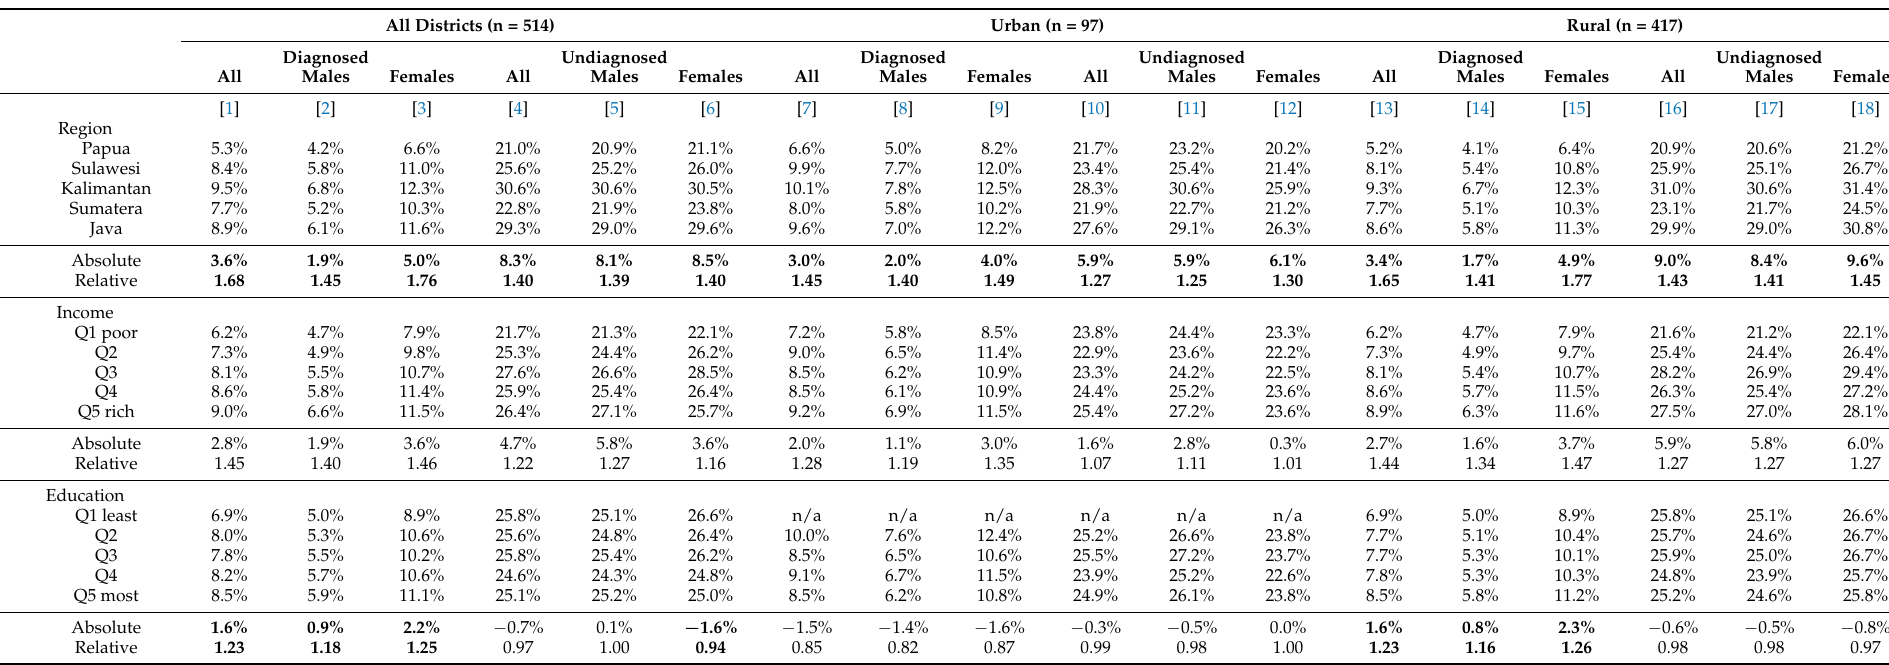
Table 3. Geographic and socioeconomic disparity in diagnosed and undiagnosed hypertension among adults (18+ years) in Indonesia,